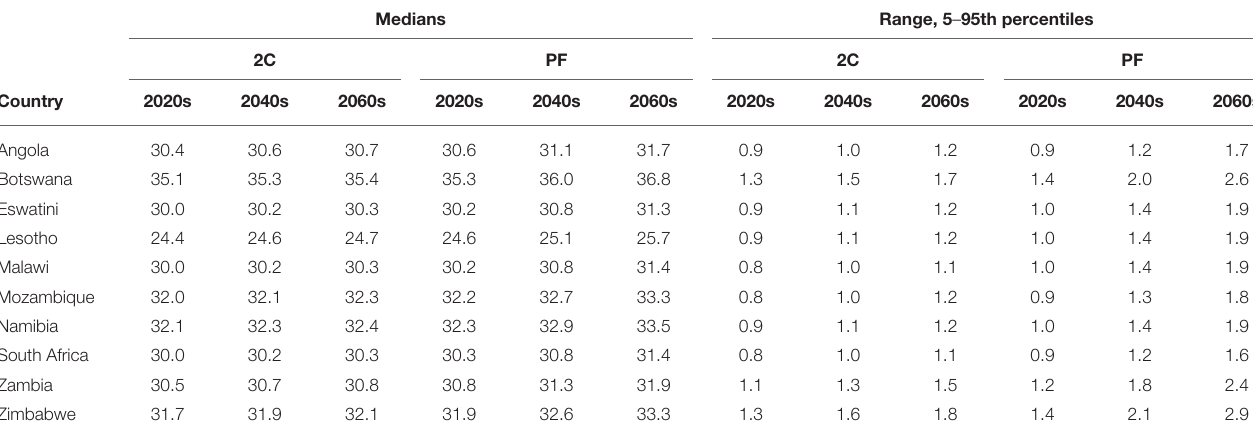
TABLE 2 | Median value for mean daily maximum temperature and variation during the wettest 3 months across climate models and multiple years in selected decades, in 0 C. Medians Range, 5 – 95th